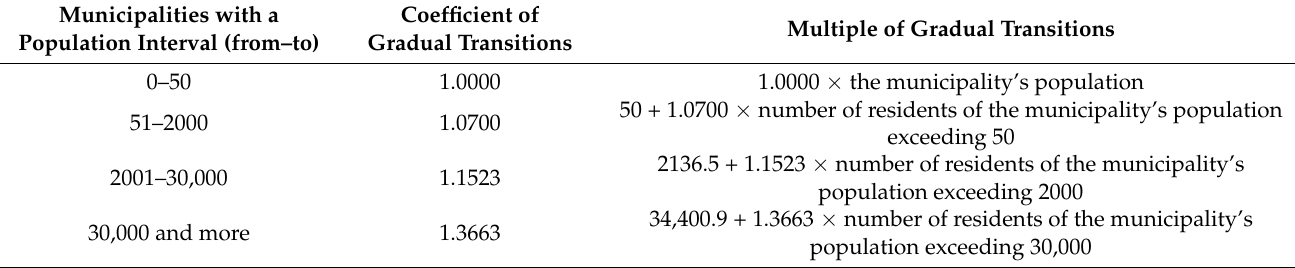
Table 1. Coefficients and multiples of gradual transitions.